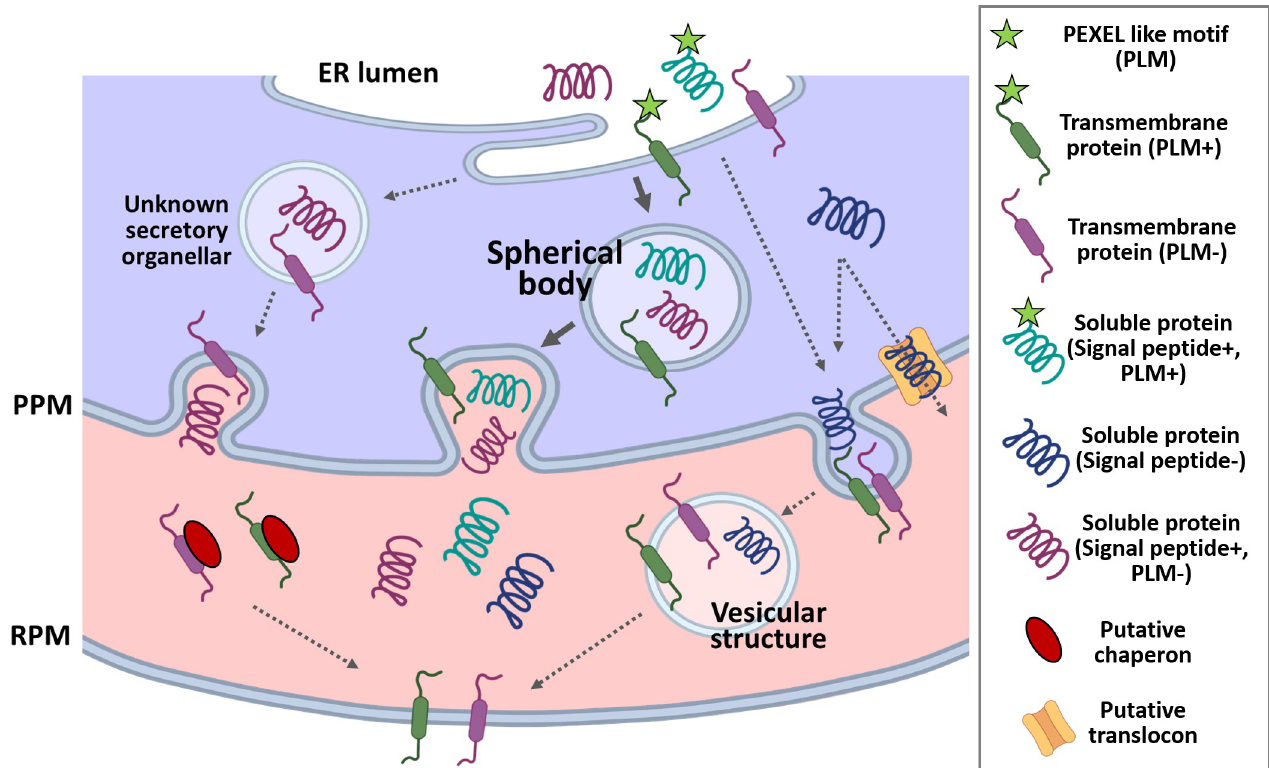
Fig 5. Schematic of the protein export pathway in Babesia iRBC. The appointed soluble proteins for the export are being recruited into ER, cleaved by signal peptidase, and likely followed by cleavage of PLM. Transmembrane-containing proteins such as VESA1 or mtm are inserted into the ER membrane. These proteins are loaded into secretory vesicles of the ER-Golgi pathway, which are being transferred to spherical bodies (in the case of spherical body proteins: SBP1, SBP2, SBP3, SBP4, VEAP, and mtm) or directly to parasite plasma membrane (in the case of VESA1). Soluble proteins are released to RBC cytoplasm, while integral protein needs to be extracted from PPM, which may involve protein translocation. Soluble protein could reach the target by diffusion, while membrane proteins are carried out to the target destination through vesicles or in complex with chaperones. It is noted that this scheme is speculative. ER, endoplasmic reticulum; iRBC, infected RBC; PLM, PEXEL-like motif; PPM, parasite plasma membrane; RBC, red blood cell; RPM, RBC plasma membrane; VESA1, variant erythrocyte surface antigen